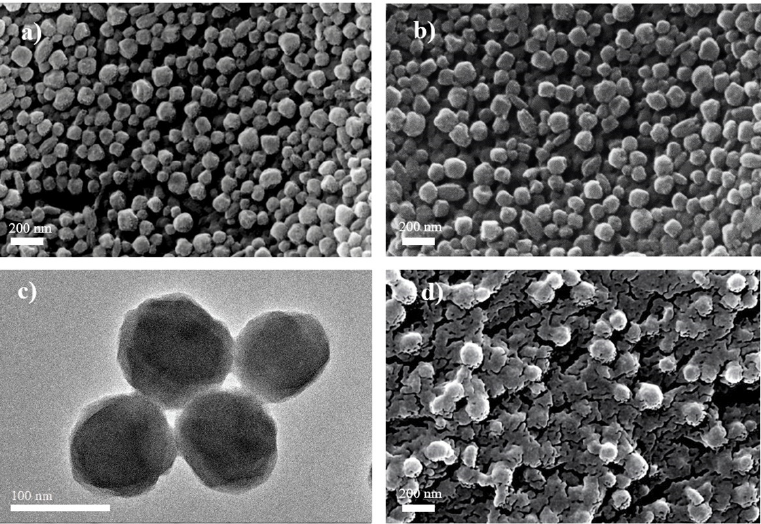
Figure 2. SEM images of ( a ) PCN-224, ( b ) Fe@PCN-224, ( d ) Fe@PCN-224/Nafion. TEM image of ( c ) Fe@PCN-224.